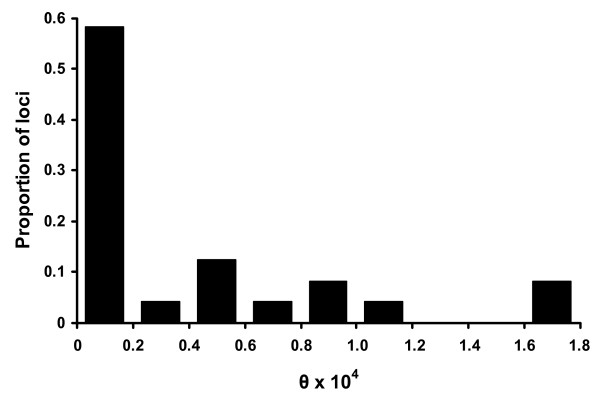
Frequency distribution of nucleotide diversities (θ) observed in the sequences of 24 independent loci (see Table 3) investigated in Atlantic salmon.